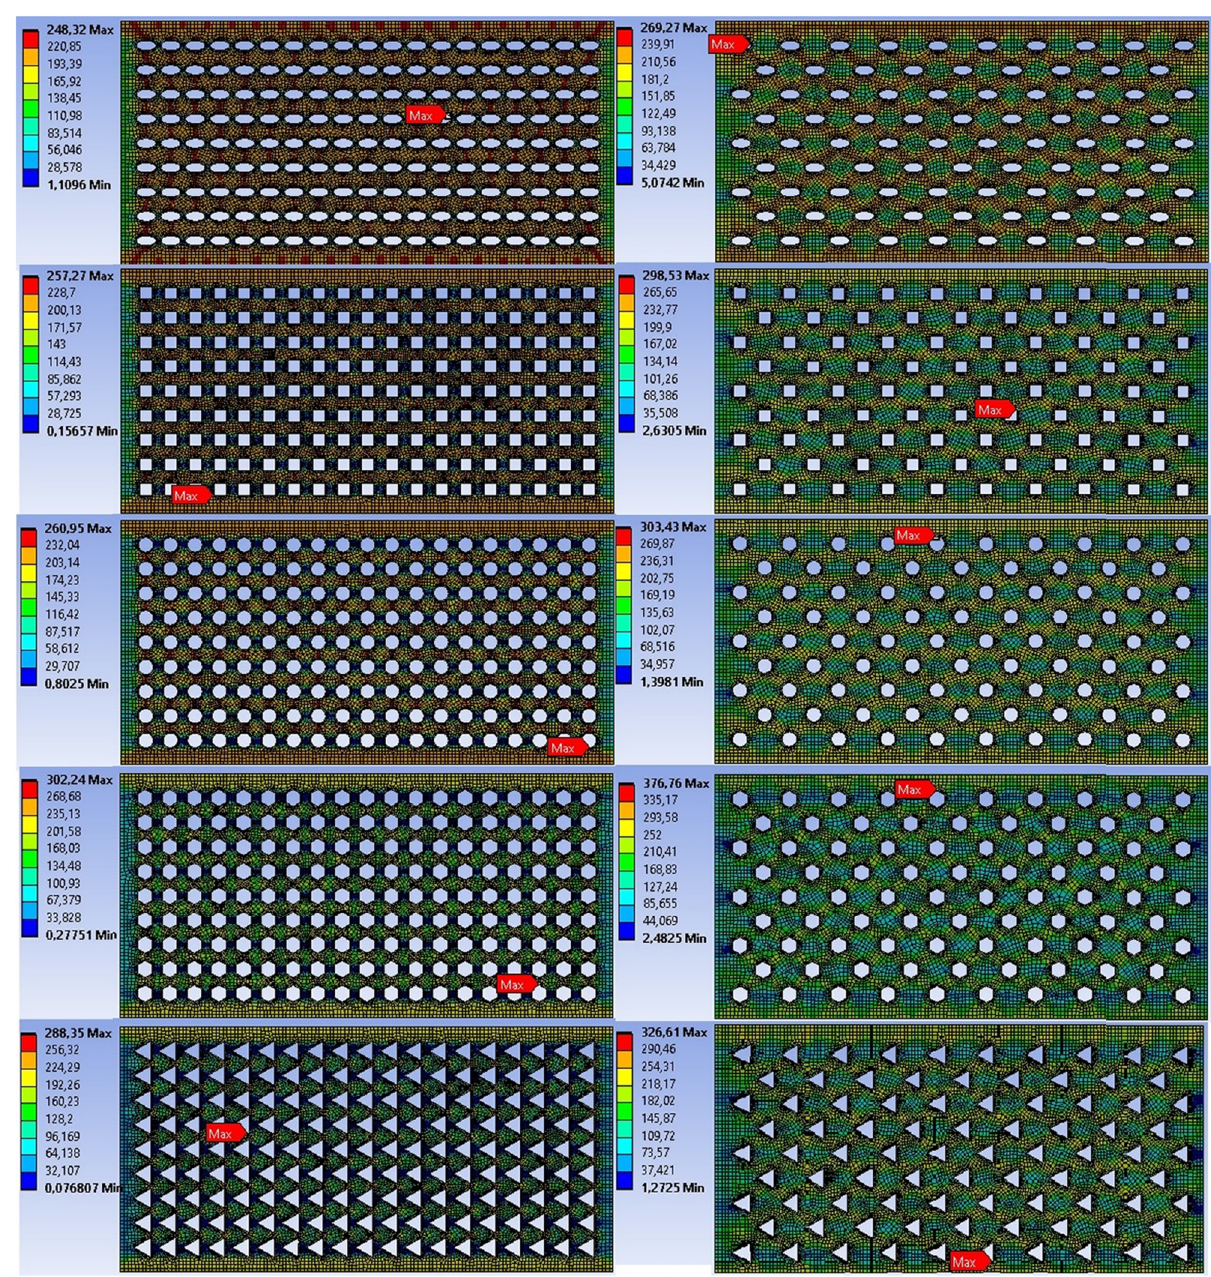
Figure 5: von Mises stress distribution of the perforated stainless - steel